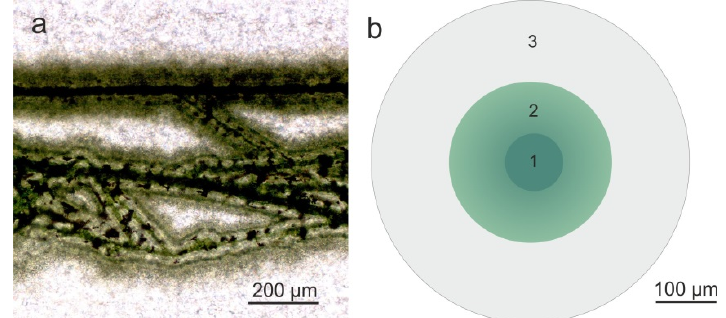
Figure 23. ( a ) Microstructure of sample Jln 01; ( b ) schematic cross-section of SFF Ma : 1 = filamentous core consisting of sheet silicates (e.g., celadonite), 2 = chalcedony intergrown with sheet silicates, 3 = pure SiO 2 .